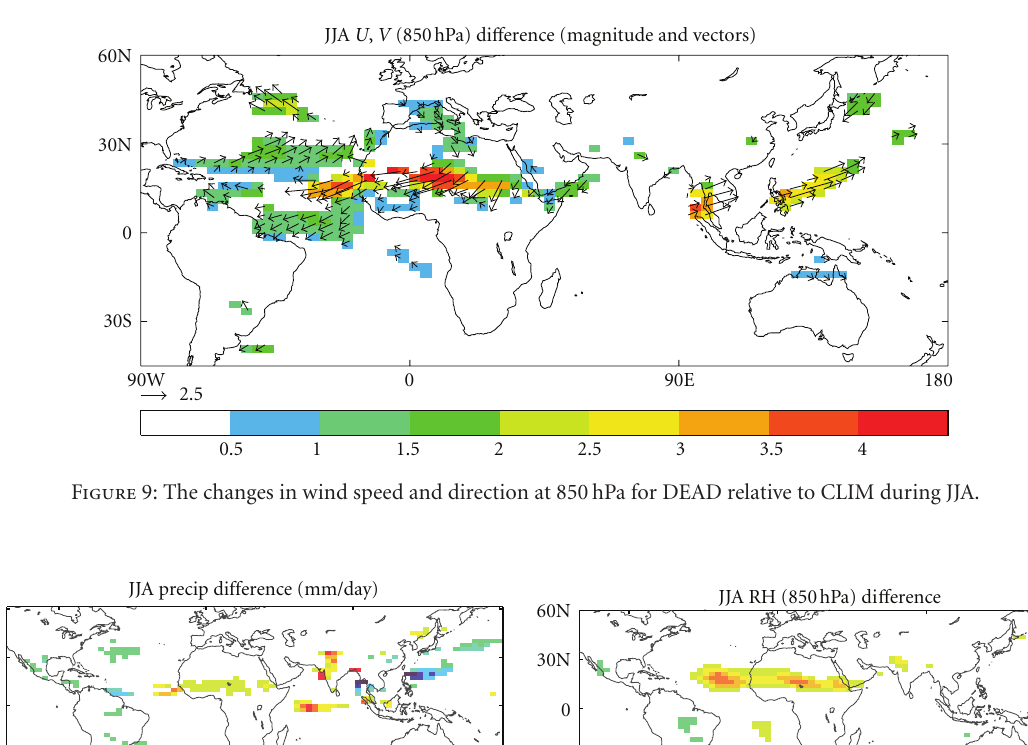
However, the AeroCom simulations only represented